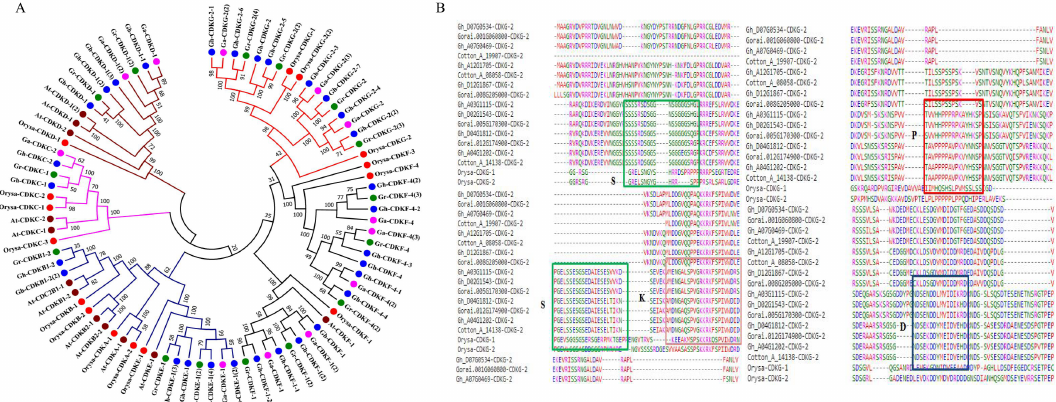
Figure 2. Phylogenetic tree and motif identification among the CDK proteins. ( A ) The neighbor-join phylogenetic tree of Cotton, Rice and Arabidopsis CDK genes. The red circle: CDKs from rice, blue: CDKs from G. hirsutum , green: CDKs from G. raimondii , brown: CDKs from Arabidopsis and purple: CDKs from G. arboreum . ( B ) Alignment of CDK motif domain. Color shading indicates types of amino acid residues conserved. S: motif, K: motif, P: motif and D: